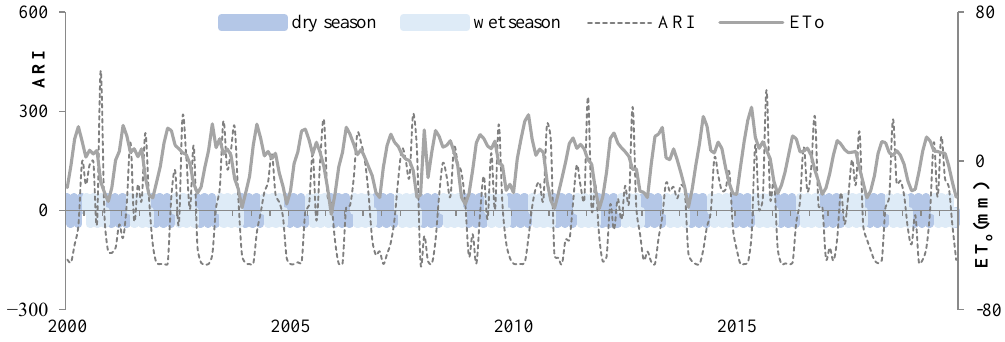
Figure 5. ARI variation both seasonally and yearly between 2000 and 2019.